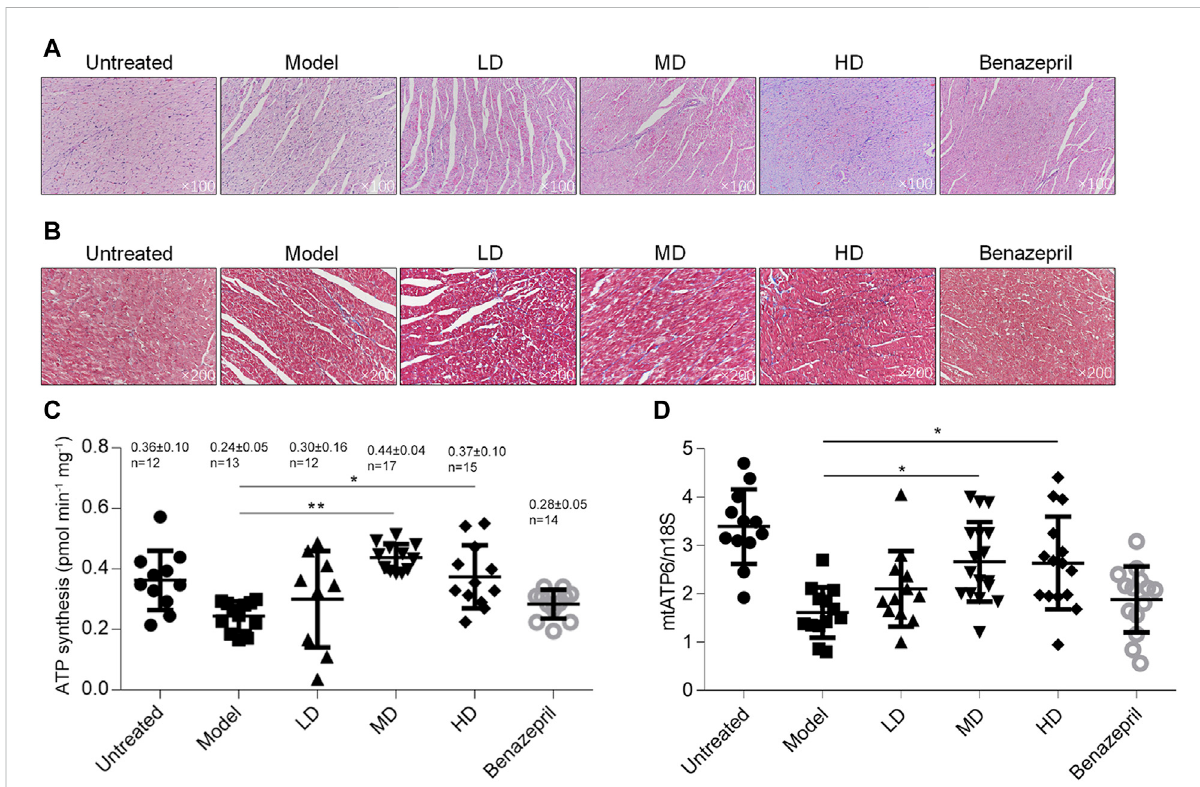
FIGURE 3 Detection of heart injury and metabolic function after the YXX keli treatment. To evaluate the myocardial injury, H&E (A) and Masson ’ s Trichrome (B) stained sections was performed. After being sacri fi ced, the left ventricle was freshly prepared and detected for ATP synthesis (C) and mitochondrial DNA mass (D) . * p < 0.05, vs. model group; ** p < 0.01, vs. model